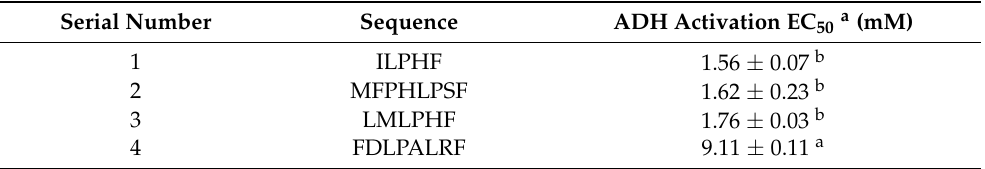
Table 3. ADH activation concentration for 50% of maximal effect (EC 50 ) of synthetic peptides in vitro. Different letters (a, b) represent significant differences at p <